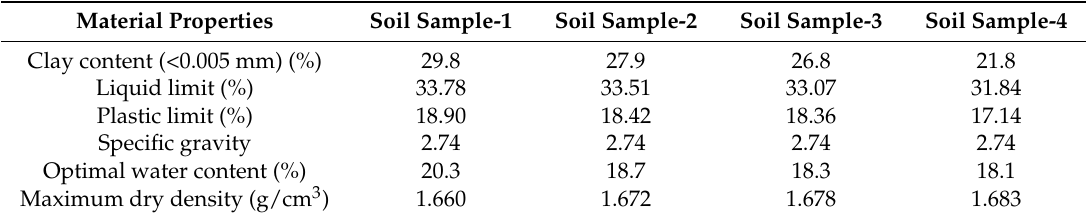
Table 1. Material properties for the tested